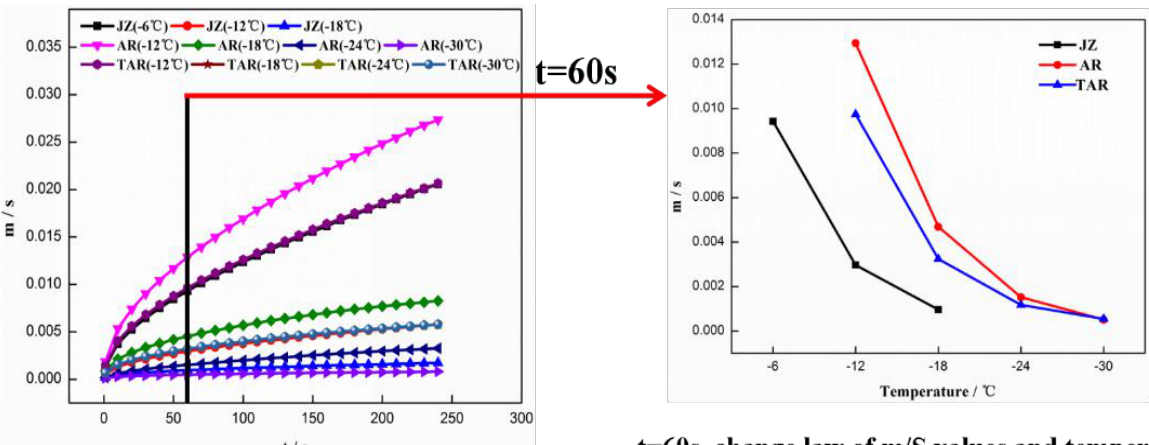
Figure 18. The variations of m/S values with loading time.